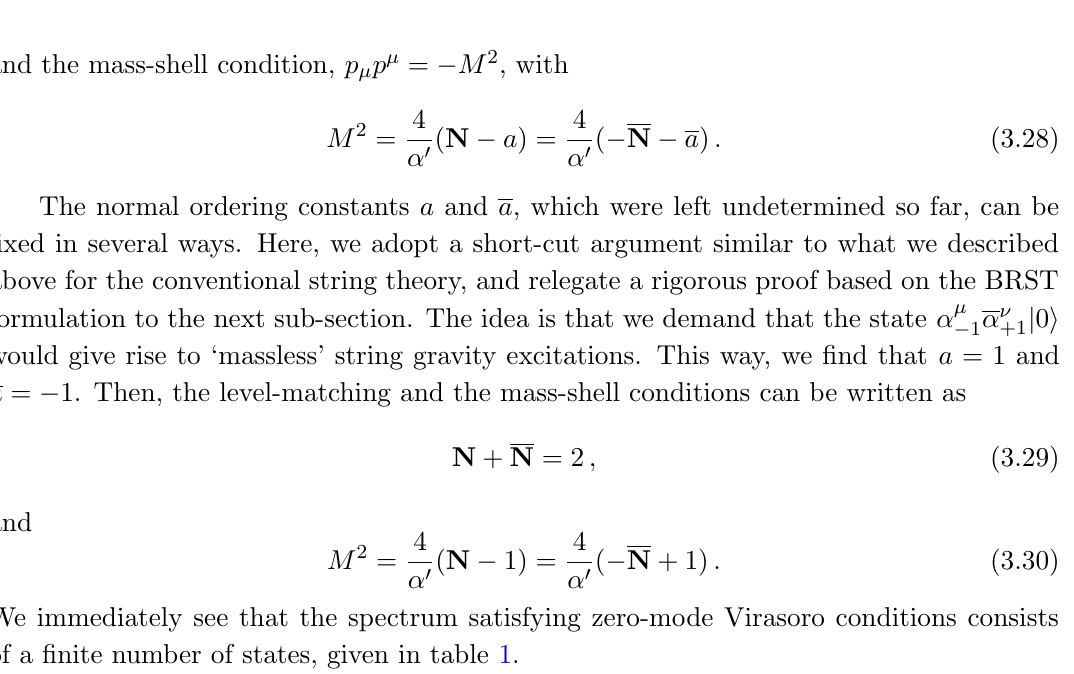
Table 1 . Spectrum satisfying the zero-mode Virasoro conditions. (cid:15) (cid:22)(cid:23) , a (cid:22)(cid:23) , a (cid:22) , (cid:22) a (cid:22)(cid:23) and (cid:22) a (cid:22) are polarization tensors of the respective